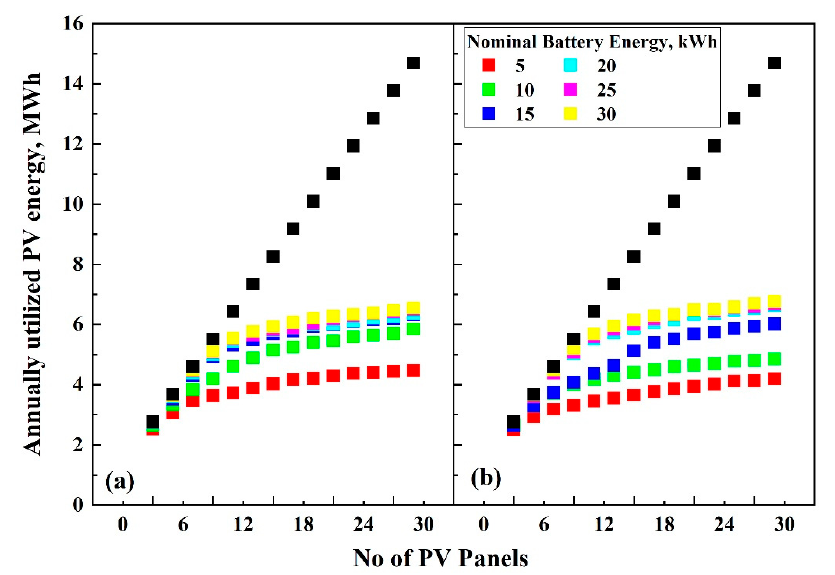
Figure 11. Comparison of the annually utilized PV output E us , as defined in Equation (14), of every lithium-ion ( a ) and lead–acid ( b ) simulation instance and the corresponding theoretically optimal photovoltaic output P pv (black marks).